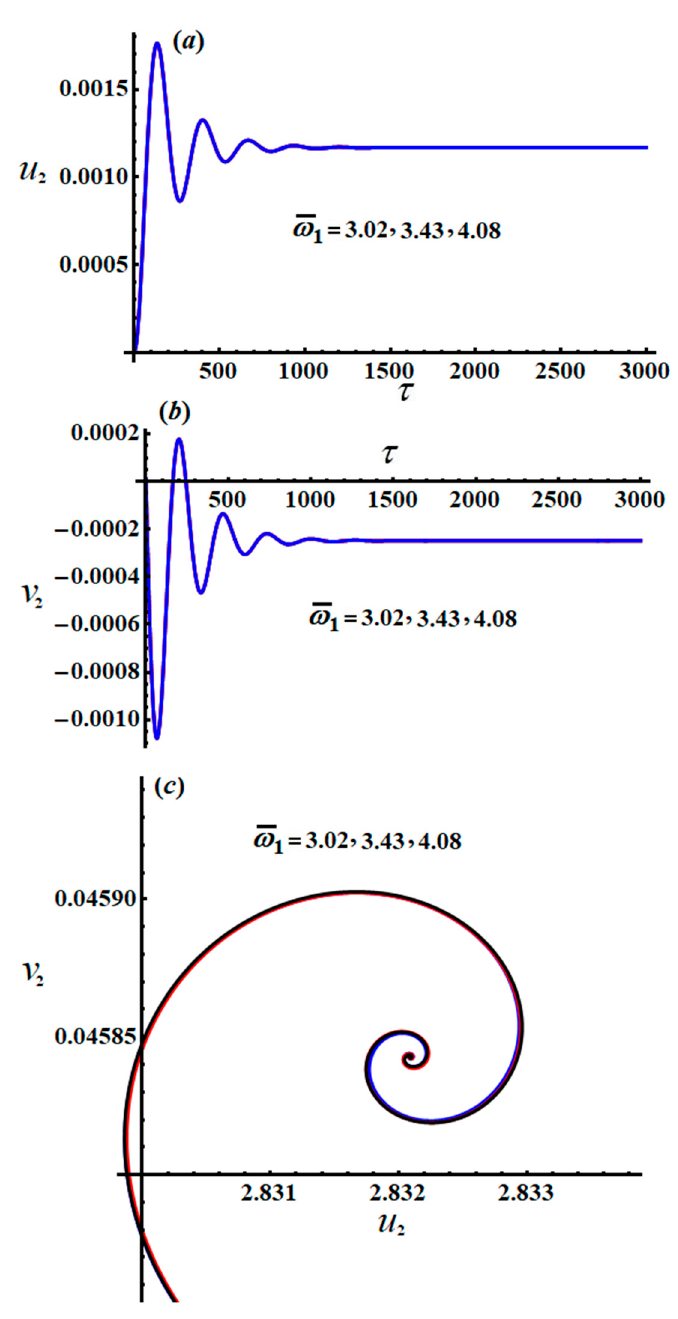
τ Figure 16. The modified amplitudes via and the projections of the modulation equation tracks Figure 16. The modified amplitudes via τ and the projections of the modulation equation tracks on on the phase plane the phase plane u 2 v 2 : ( a – c ) when ω 1 = ( 3.02,3.43,4.08 )